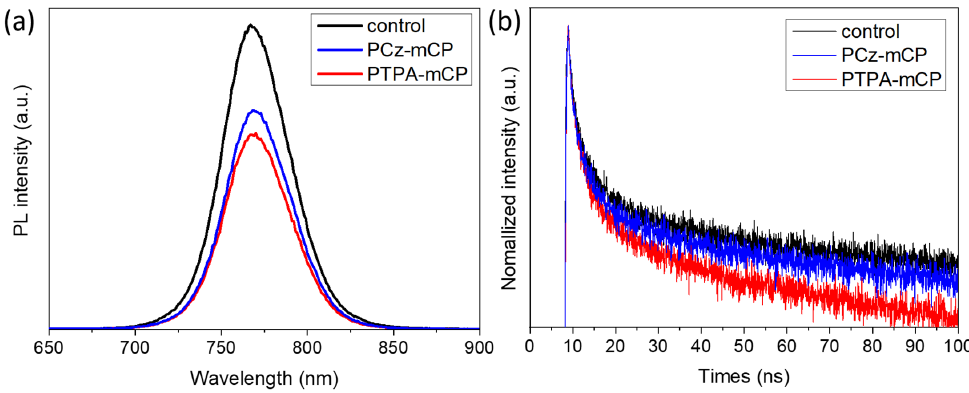
Figure 3. ( a ) PL spectrum of the control film, PCz-mCP, and PTPA-mCP modified perovskite films; ( b ) TRPL spectrum of the control and modified film measured by the structure of FTO/SnO 2 /perovskite.